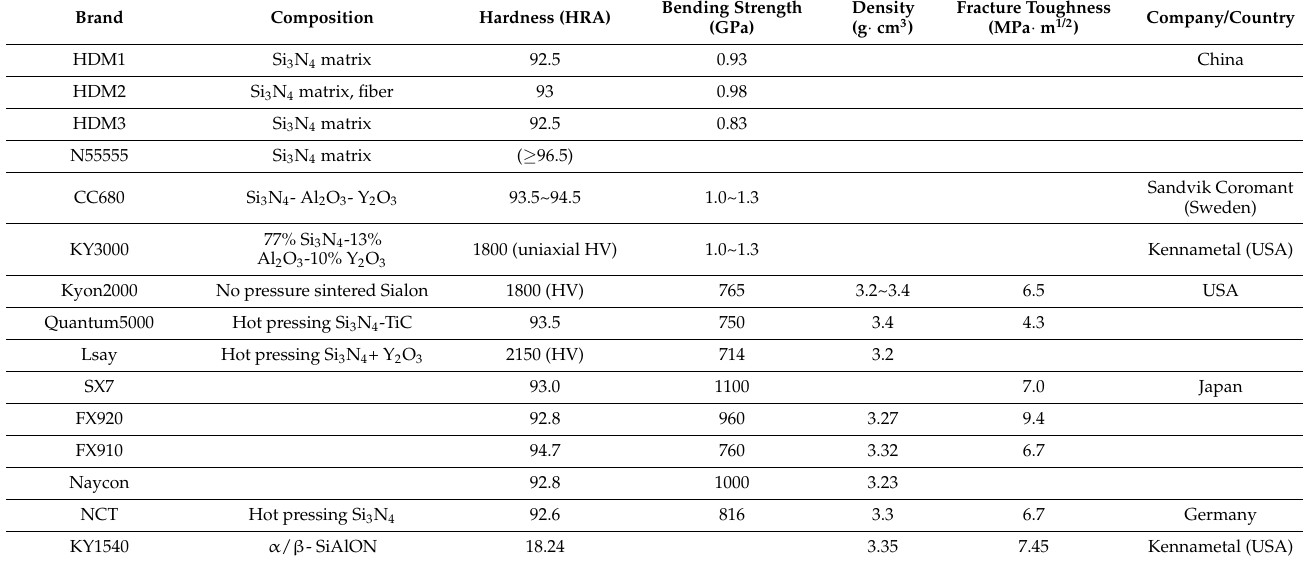
Table 3. Various categories, compositions, and properties of Si 3 N 4 -based ceramic